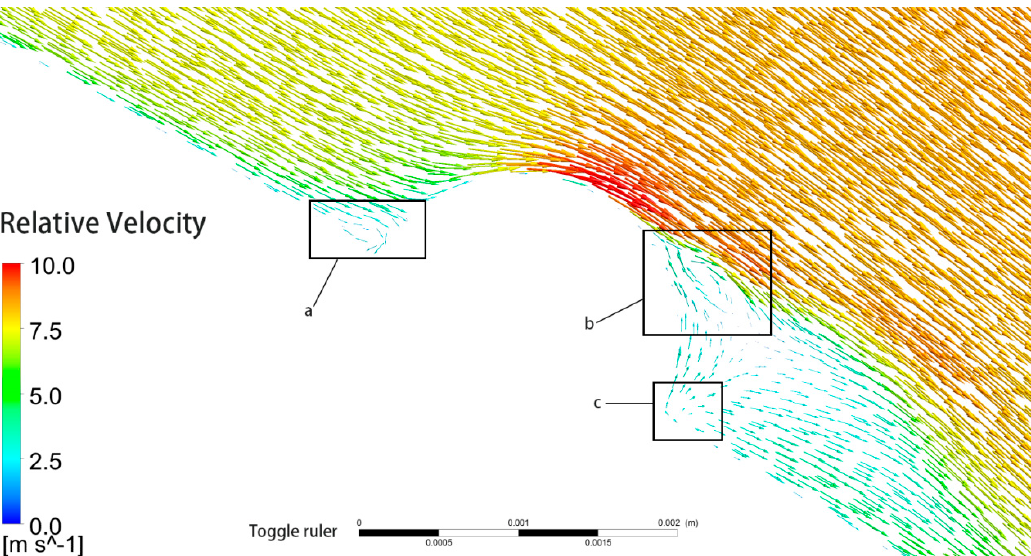
Figure 27. The sketch of the location chosen for the comparison of the relative-velocity distribution around the prototype blade surface and the blade surface with the bionic convex domes (units: m/s).